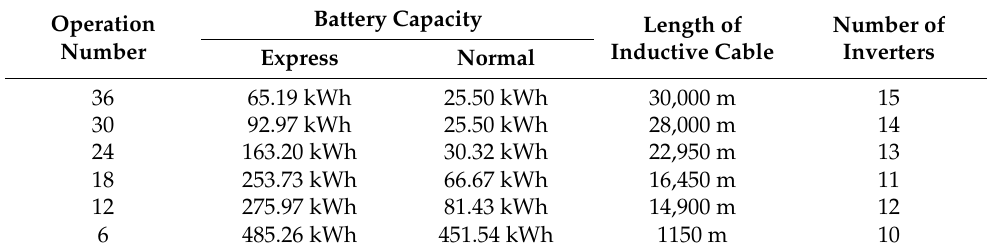
Table 7. Variation of the decision variables about the number of